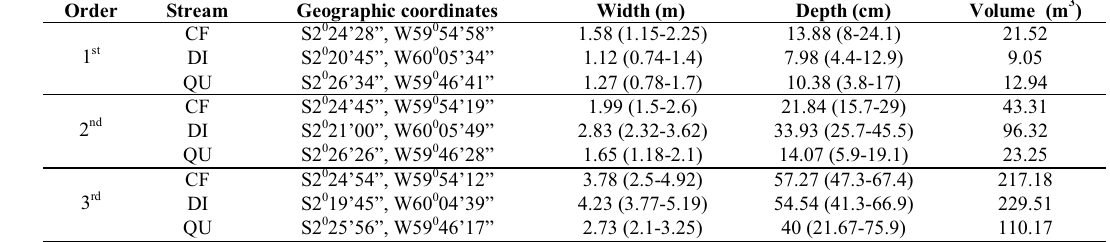
Table 1. Geographic localization and mean values (minimum - maximum) of environmental parameters of 100-m stream seg- ments of 1 st , 2 nd , and 3 rd order located in the study areas of Biological Dynamics of Forest Fragments Project, Manaus, Amazonas